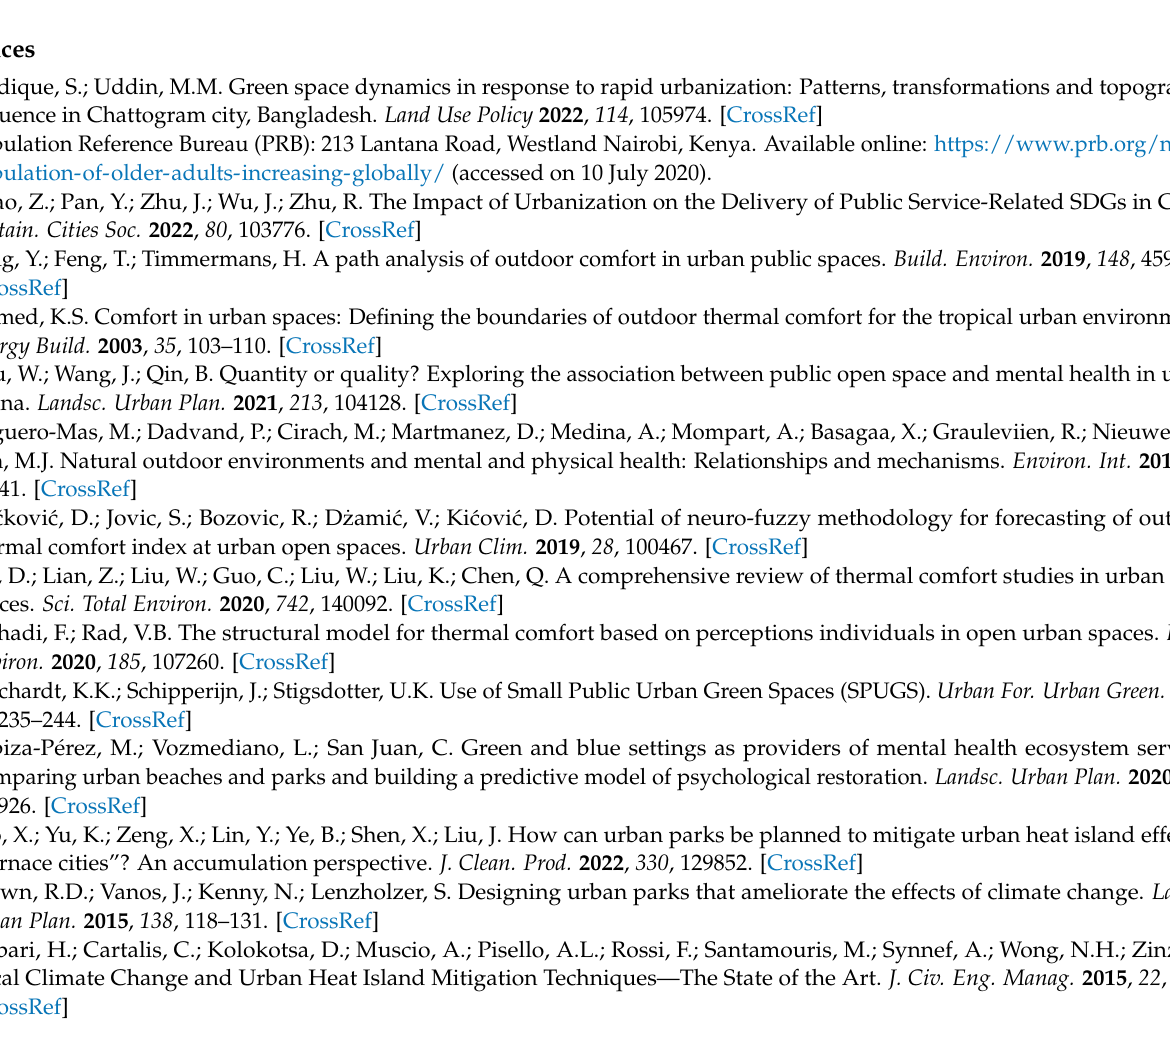
Table S1. For raw data radar files, contact